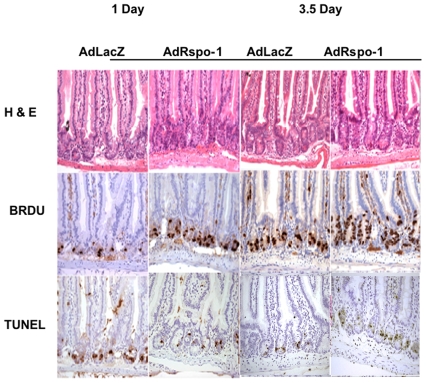
Histolological assessment of intestine after Irradiation.H&E staining demonstrates increased crypt depth and increased villi thickness in AdRspo1-treated animals following exposure to WBI. BrdU immunohistochemistry demonstrates higher crypt cell proliferation after AdRspo1 treatment when compared to AdLacZ cohorts. Finally, TUNEL staining demonstrates a decrease in the rate of TUNEL-positive, apoptotic cells in AdRspo1-treated mice post-WBI, when compared to intestinal lumen of AdLacZ-treated mice.